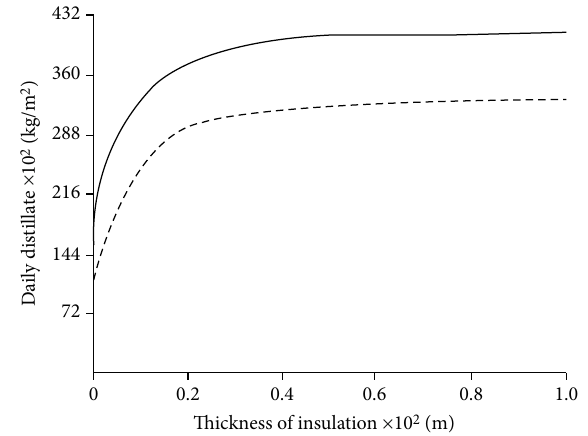
Figure 31: E ff ect of insulation thickness on distilled water (continuous line for the coupled solar still and dotted line for the conventional solar still) [79].